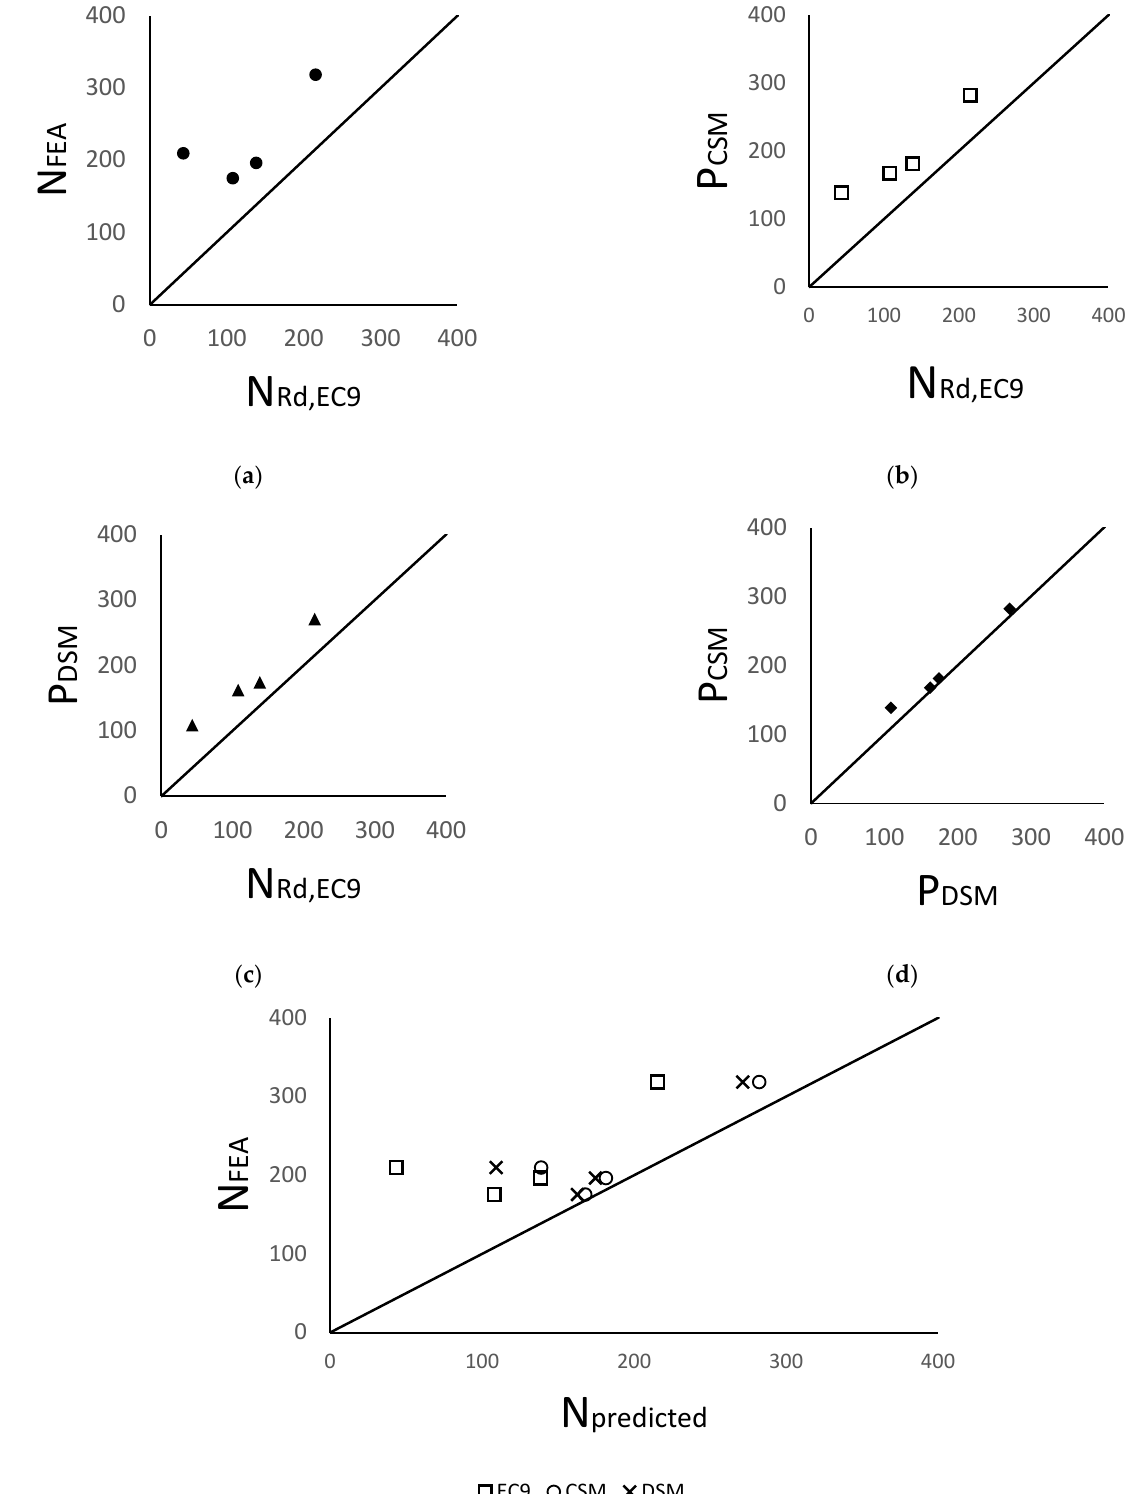
Figure 8. Slender cross-sections: Comparison between the maximum compressive resistances ob- tained from: ( a ) FEA vs. EC9; ( b ) CSM vs. EC9; ( c ) DSM vs. EC9; ( d ) CSM vs. DSM; ( e ) FEA-obtained values vs. predictions from different methods, EC9, CSM, and DSM.